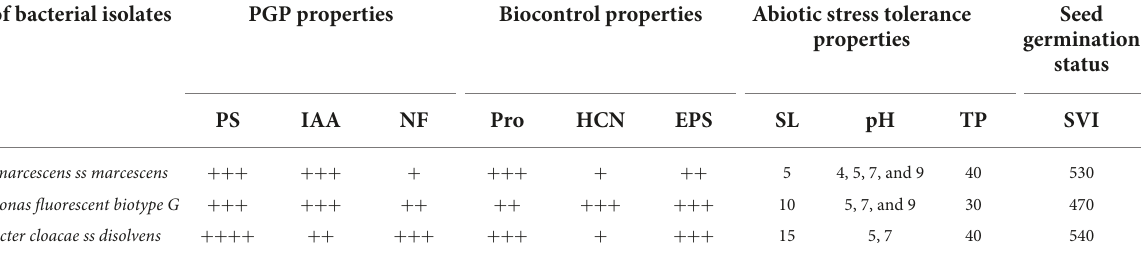
TABLE 1 Potential PGPR strains were selected for the field experimental trail. Code of bacterial